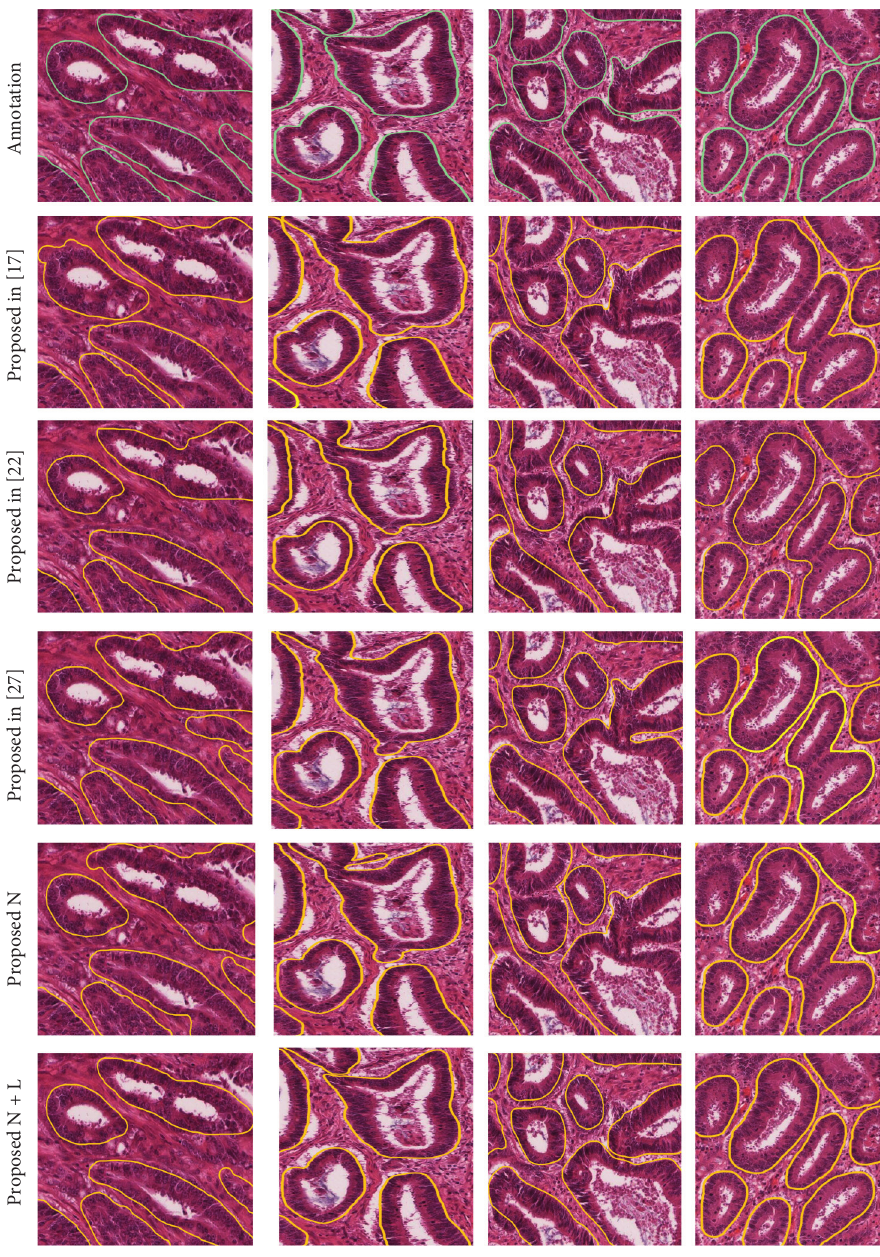
Figure 14: The segmentation outcomes for multiple instances on the independent dataset, where green is the manually annotated contour and yellow is the segmentation contour by different